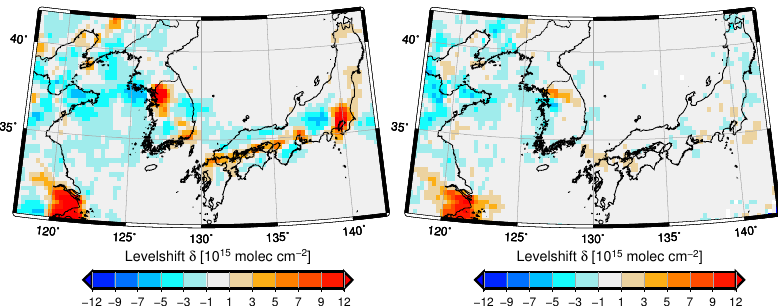
Fig. 13. Comparison of level shift offset δ between the original (left) and resolution-corrected (right) GOME measurements and the SCIA- MACHY dataset.